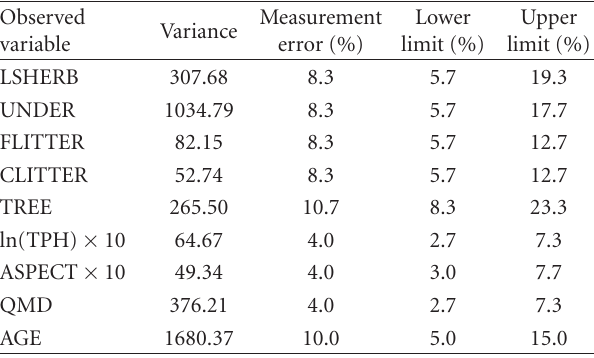
Table 1: Variance of observed variables and measurement error as average percent variance of the variable, with corresponding lower (0.025 quantile) and upper (0.975 quantile) limits a